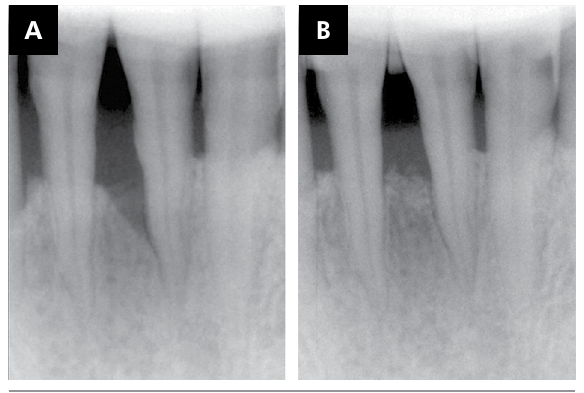
Figure 4. Control group: (A) periapical radiograph of the intra-bony defect at baseline; (B) periapical radiograph of the intra-bony defect at 6 months after ABBM